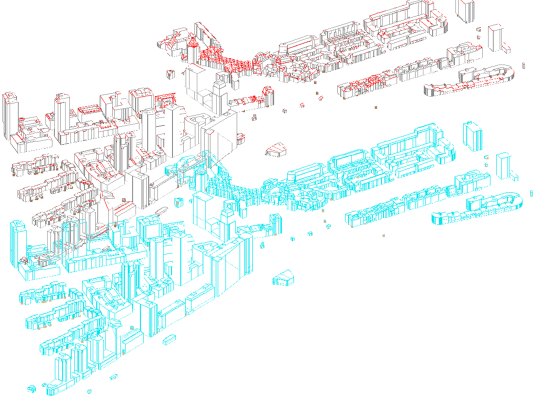
Figure 8. CityGML dataset representing a Rotterdam district in LoD 1 and LoD 2. Source of the data: City of